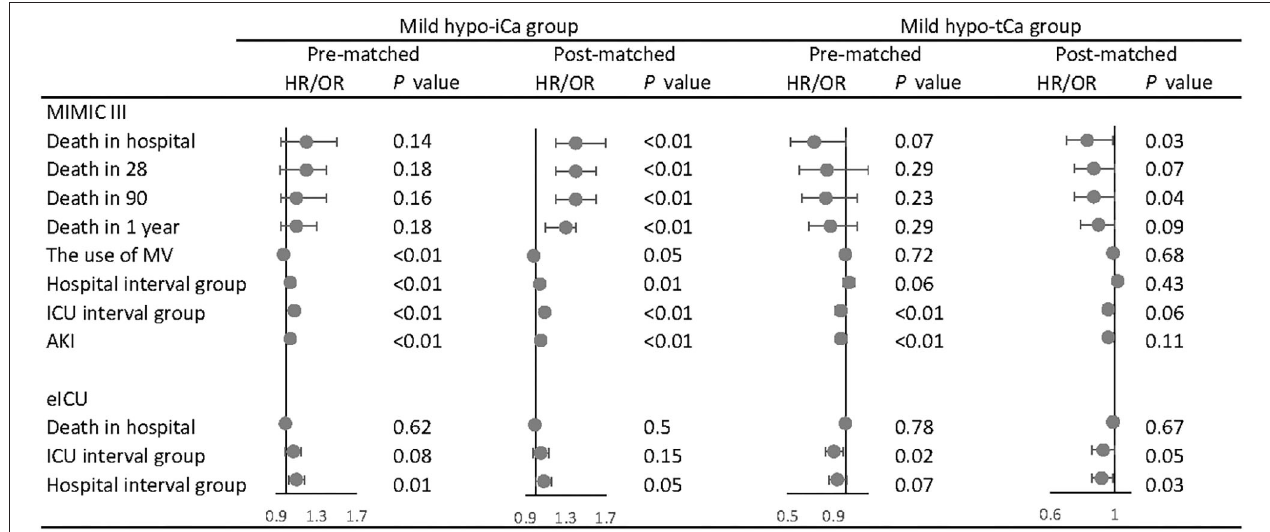
FIGURE 3 | The association between mild hypocalcemia and outcomes. The forest plot represents the hazard ratios (HR) or odds ratios (OR) and 95% confidence intervals (error bars).